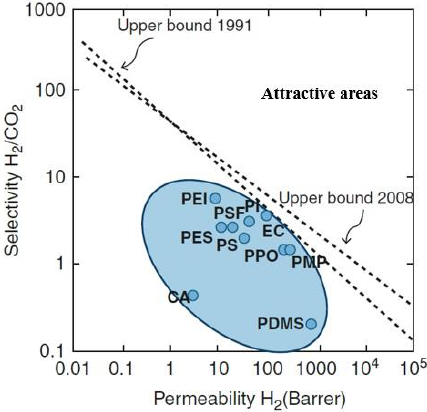
Figure 4. Roberson upper boundary for H 2 /CO 2 separation [32,45,46]. The blue area indicates the performance range of the membranes fabricated from commercially available polymers. CA: cellulose acetate; PSF: polysulfone; PES: polyethersulfone; PI: polyimide; PEI: polyetherimide; PDMS: polydimethylsiloxane; PMP: polymethylpentene; PPO: poly(phenylene oxide); PS: polystyrene; EC: ethyl